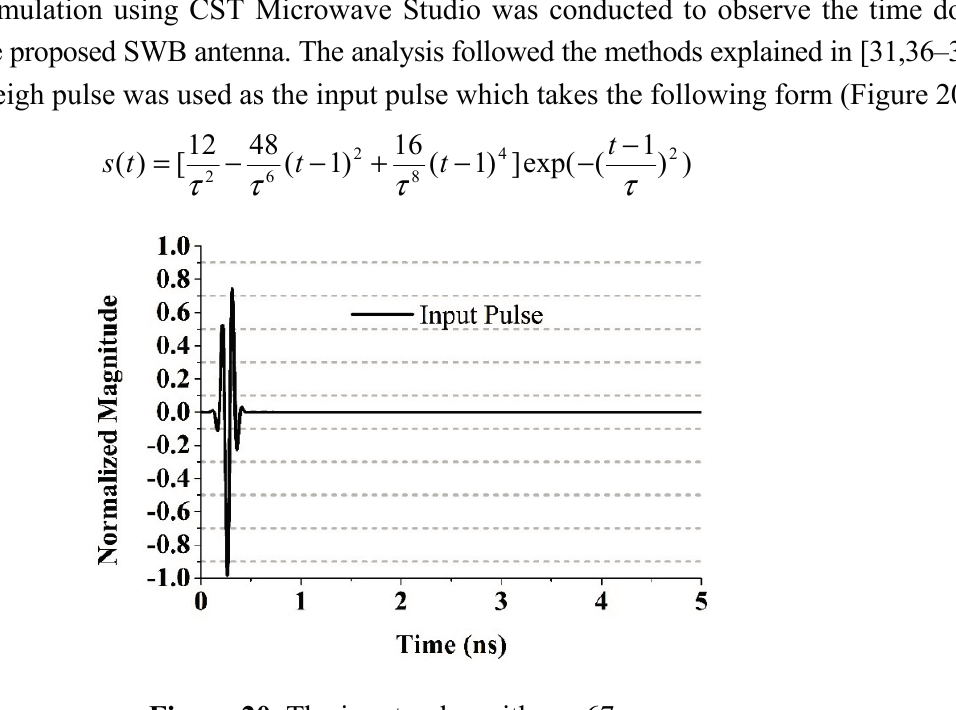
Figure 20. The input pulse with τ = 67